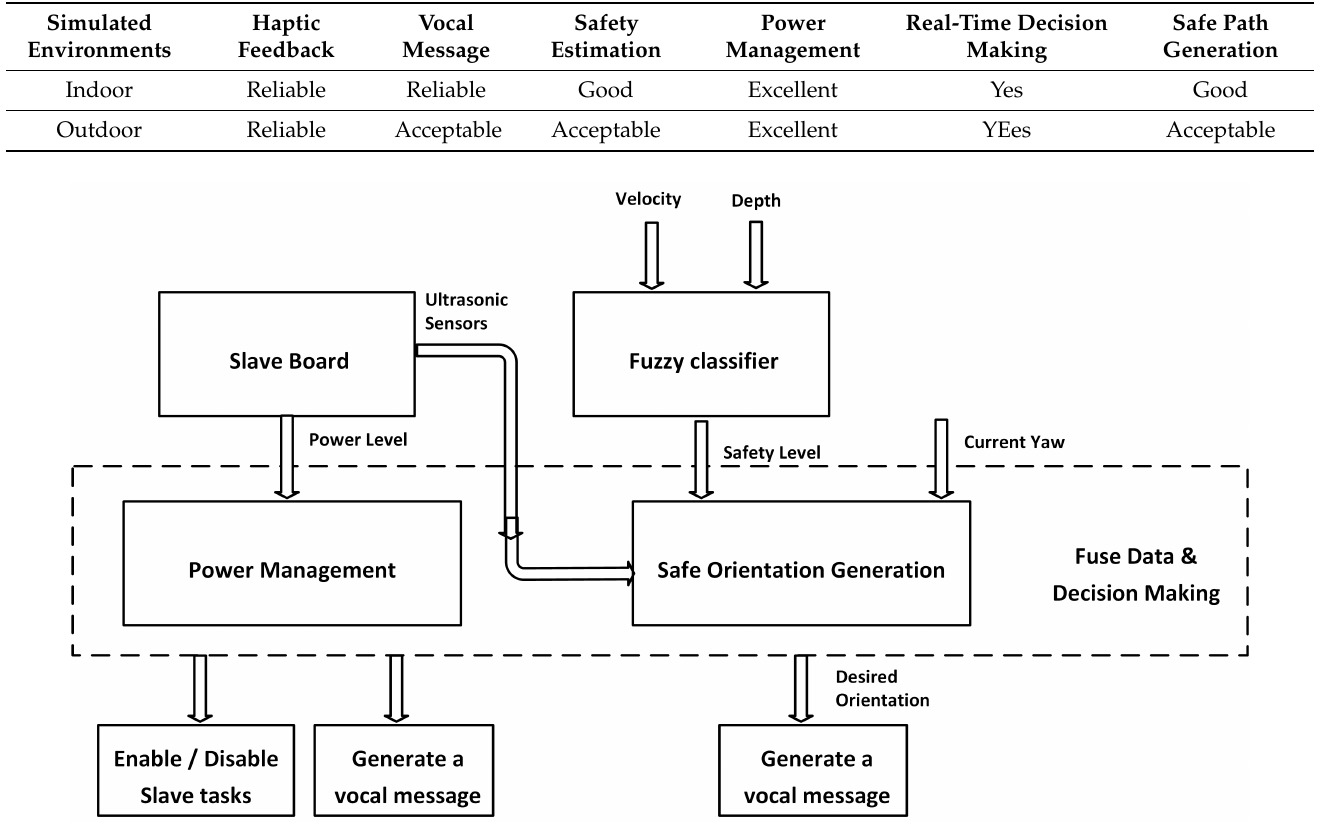
Table 2. Proof-of-concept results.